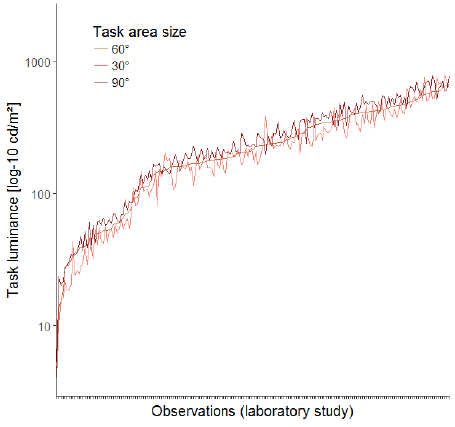
Figure 31. Comparison of the task area average luminance between the 3 different task area sizes for all glare evaluations of the lab study.